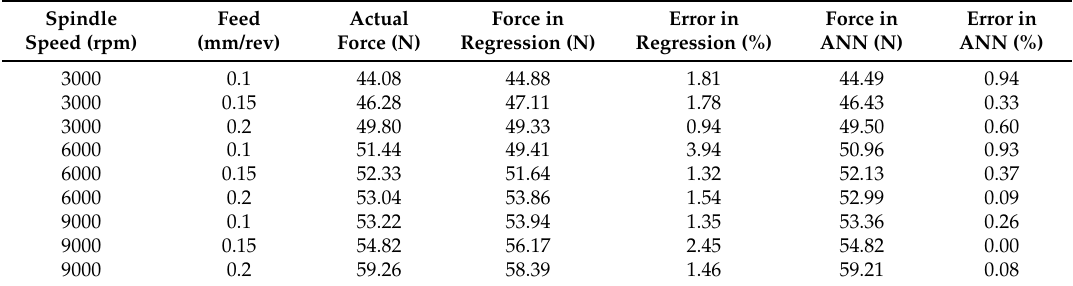
Table 10. Predicted cutting forces using regression model and ANN model for tool T3.